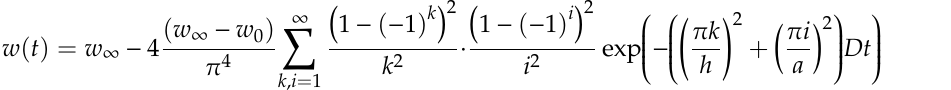
Figure 4. ( a ) Storage modulus ( E ’) and loss factor (tan δ ) of the epoxy ( 1 ) and epoxy filled with 0.05 wt. % of CNT ( 2 ), 0.1 wt. % of HN ( 3 ), and 0.3 wt. % of CNF ( 4 ) vs. temperature before the hydrothermal aging; ( b ) glass transition temperature ( T g ) vs. filler weight fraction for the materials studied (dots—experimental data, line—polynomial approximation).